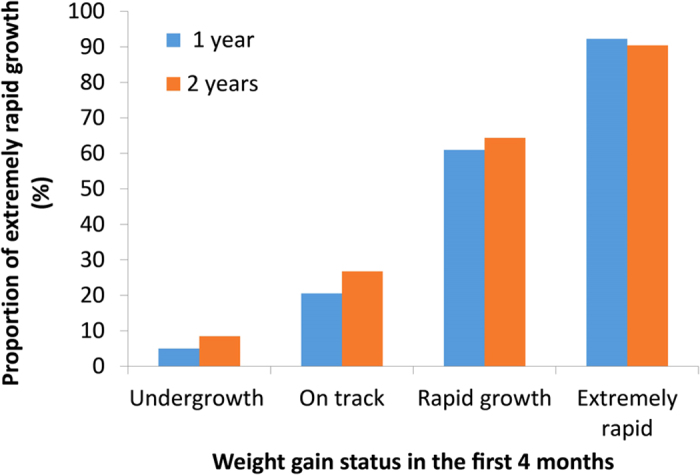
Proportion of extremely rapid weight gain in the first year and first 2 years according to weight gain status in the first 4 months of life.Weight gain z-score was defined as the change in weight for age z–score between birth and age 4 months and was categorized into four groups: slow (weight gain z-score less than −0.67); on track (weight gain z-score between −0.67 and 0.67), rapid (weight gain z-score between 0.67 and 1.28), and extremely rapid (weight gain z-score greater than 1.28).